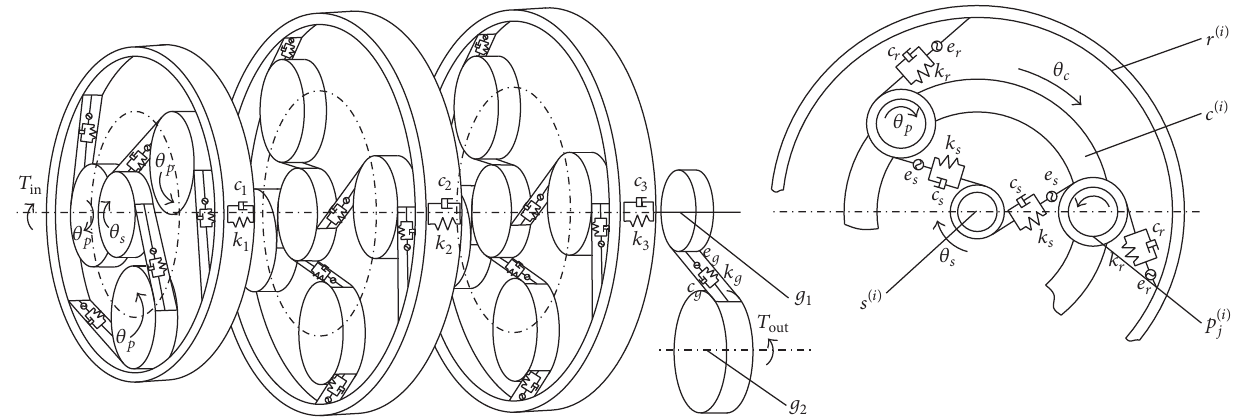
Figure 5: Purely torsional dynamic model of multistage gear transmission